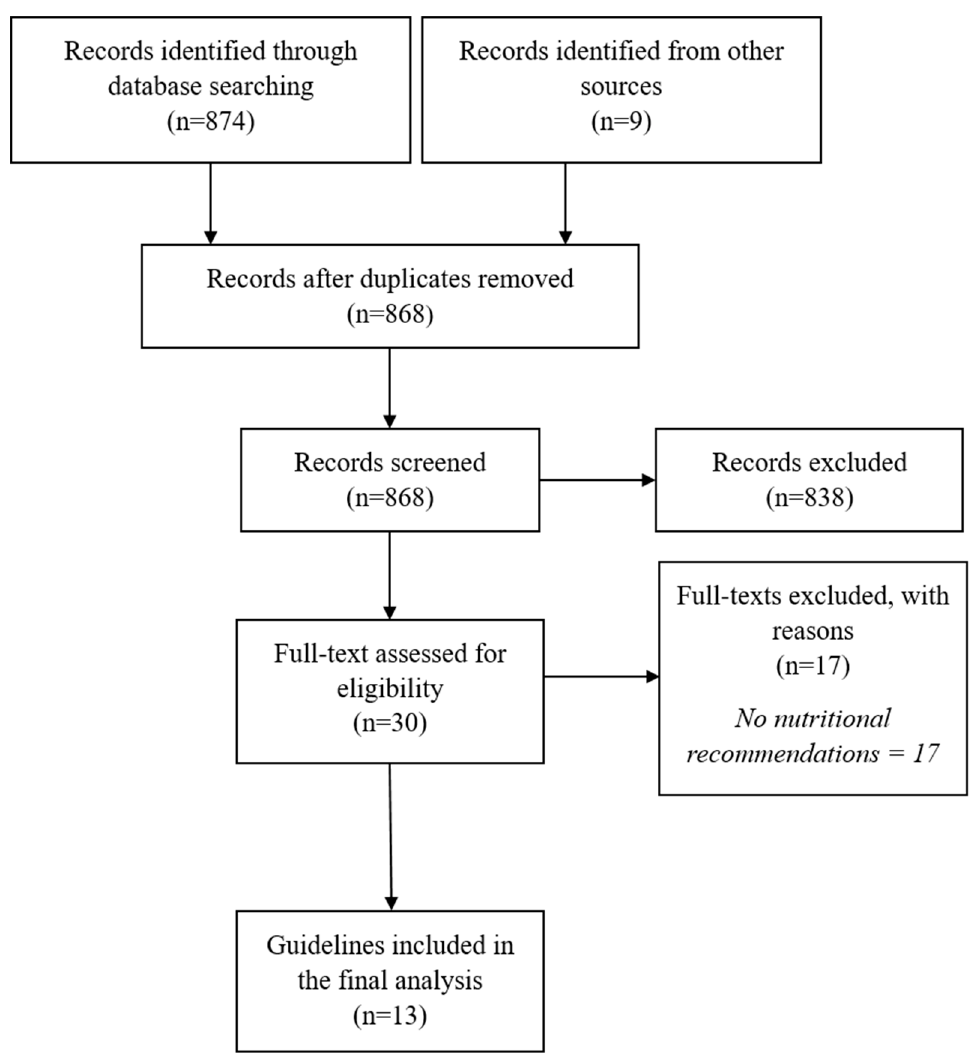
Figure 1. Selection process for identifying relevant clinical practice guidelines.